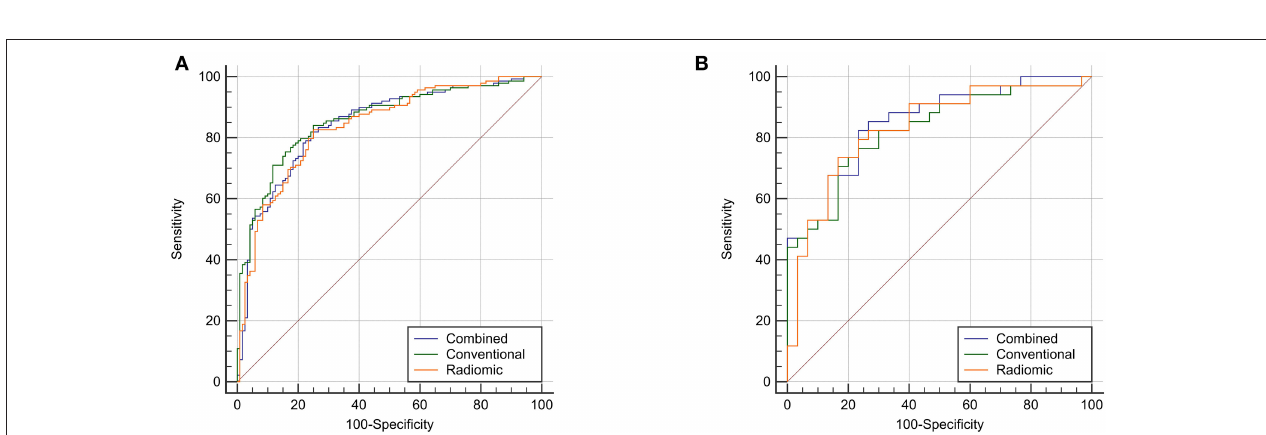
FIGURE 4 | The ROC analysis of the three different predictive model. Three predictive models presented good performance in discrimination between pGGN-like IVA and AIS/MIA. (A) , the predictive performance of three models in the 693 training cohort; (B) , the predictive performance of three models in the testing cohort.